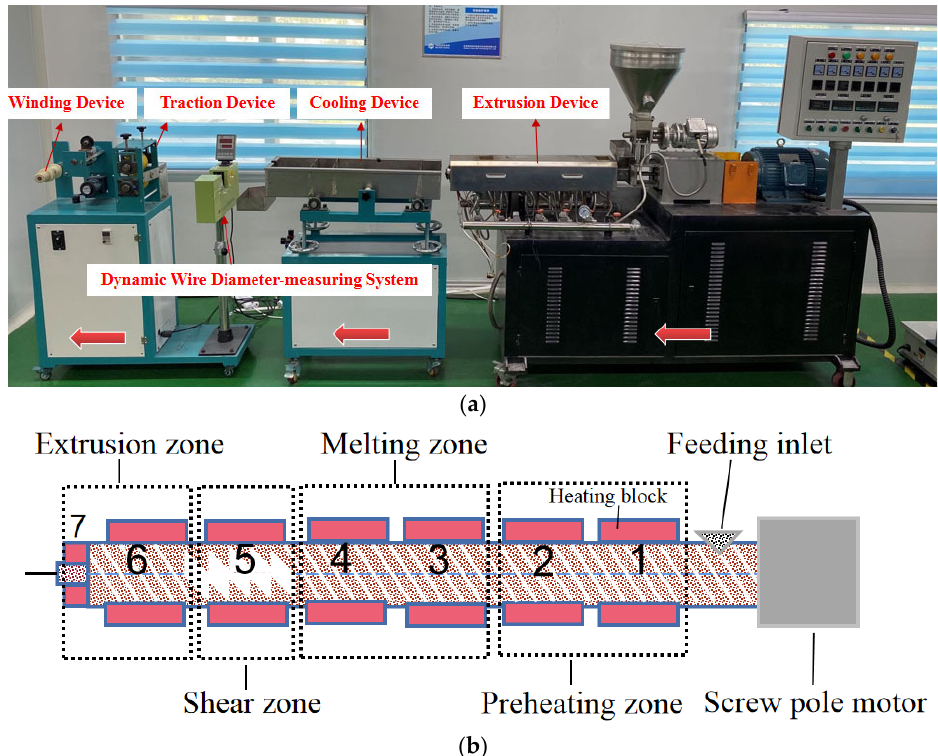
Figure 2. Preparation process of PEEK and PEEK composite fused deposition modeling (FDM) 3D printing shielding wire: ( a ) a picture of the screw extruder equipment, ( b ) the heating zones of the extrusion device.